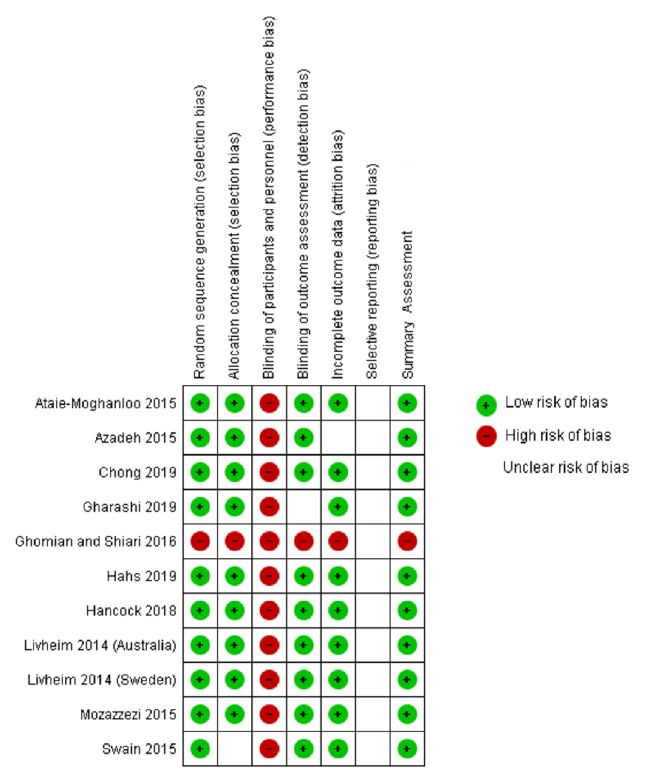
Figure 4. Risk of bias summary: review authors’ judgements about each risk of bias item presented as percentages across all included studies.